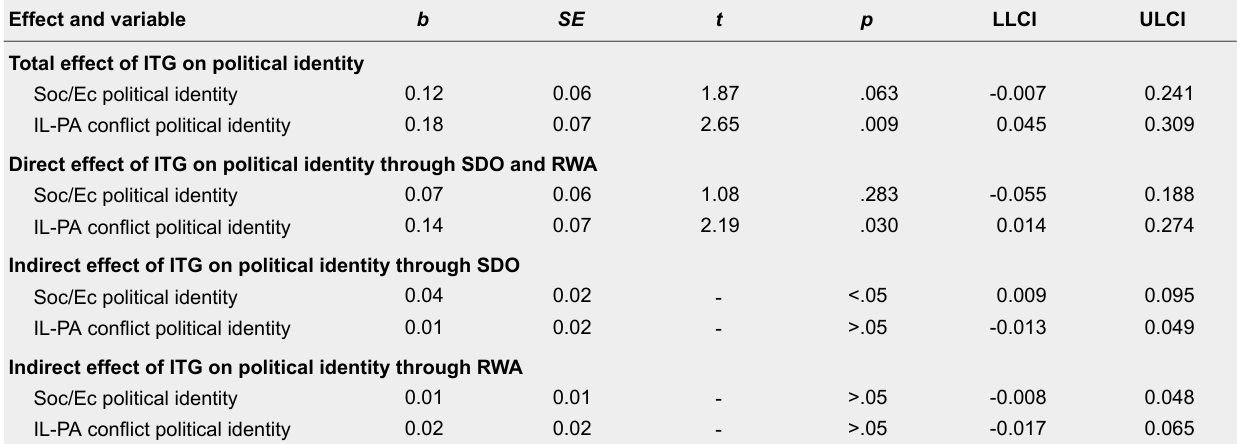
Total, Direct and Indirect Effects of ITG on Political Identity Through SDO and RWA – Study 3